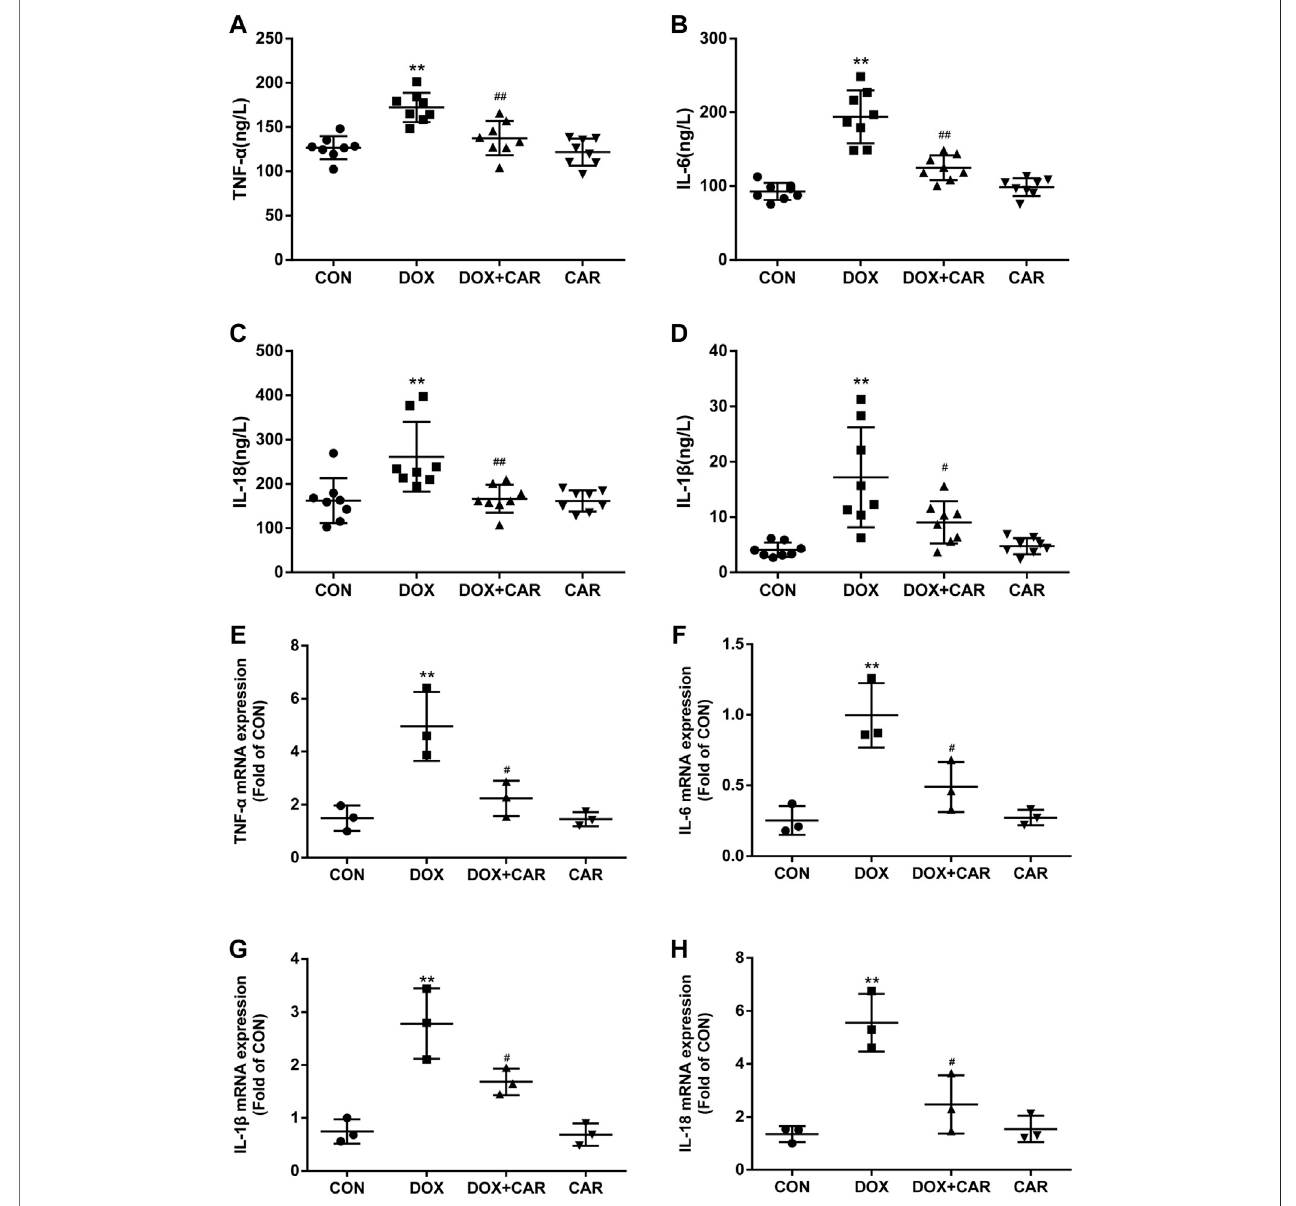
FIGURE4| CARalleviatedtheserumlevelsand mRNAexpressionsofin fl ammatorycytokinesinDOX-treatedrats.Quantitativeanalysisofserumlevels (A) TNF- α , (B) IL-6, (C) IL-18 and (D) IL-1 β ; Quantitative data are means ± SEM (n = 8). Quantitative analysis of mRNA expressions (E) TNF- α , (F) IL-6, (G) IL-18 and (H) IL-1 β . Quantitative data are means ± SEM (n = 3). One-way ANOVA followed by post hoc Tukey ’ s test. ** p < 0.01 vs. CON; # p < 0.05, ## p < 0.01 vs. DOX.